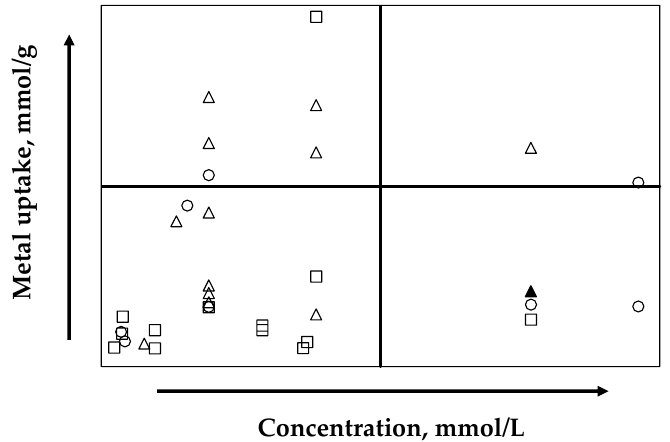
Figure 11. Global comparison of copper uptake and working concentration of G. chilensis ( ▲) (this study) with other biomasses reported in the literature. Fungi ( ); Bacteria ( Ο ); and Alga ( Δ ).